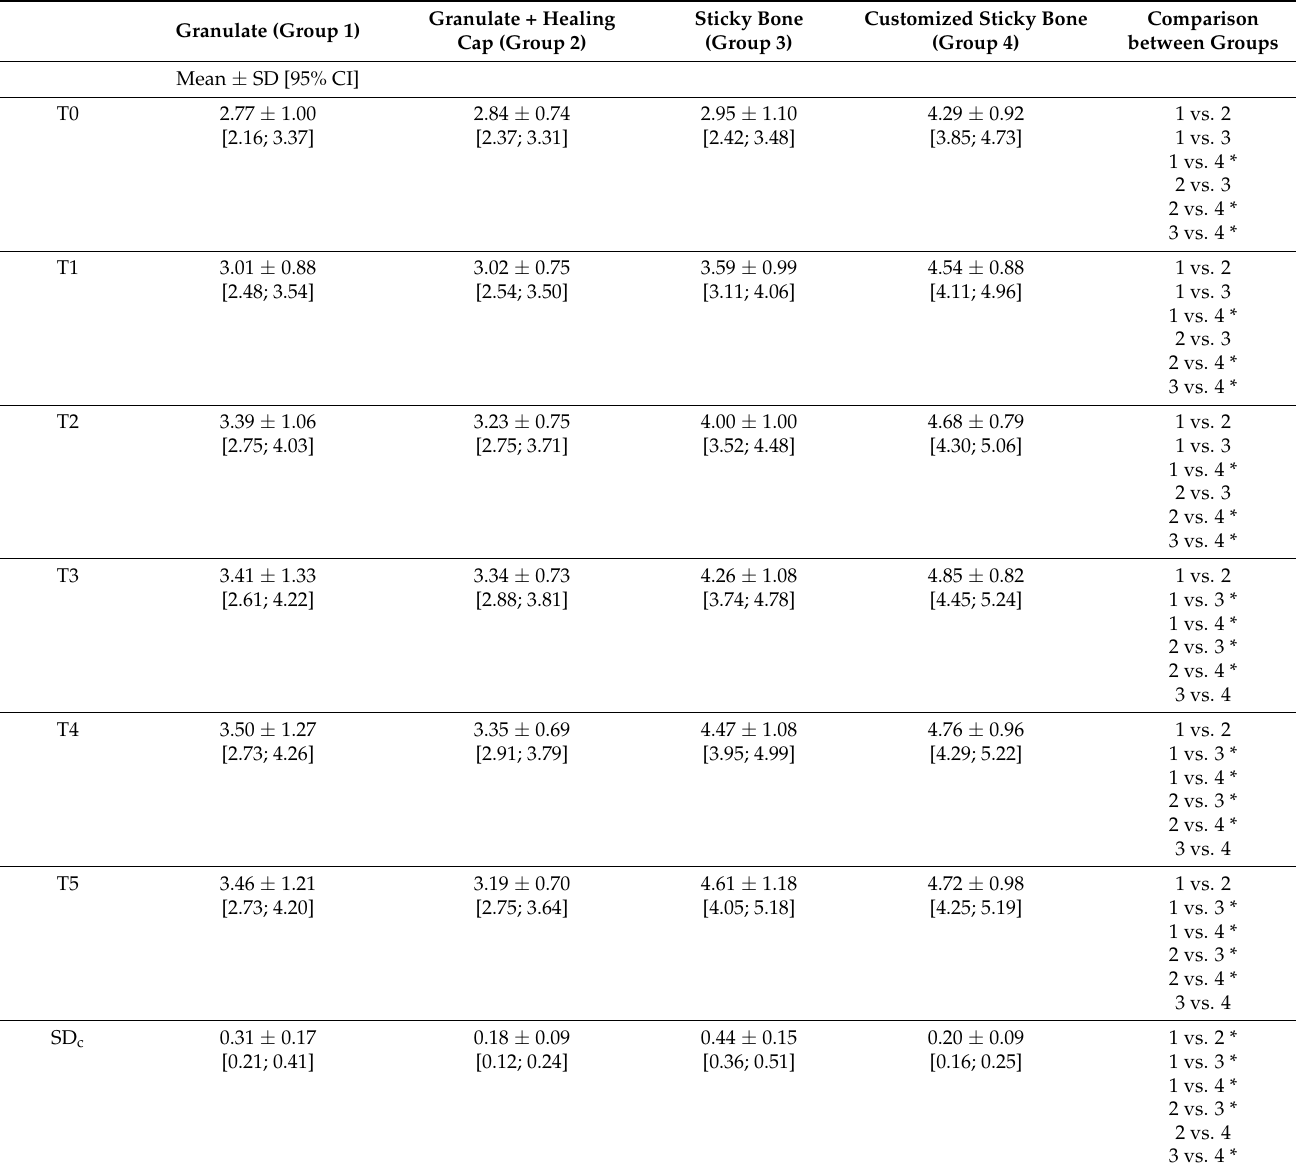
Table 3. Results of labial graft thickness after wound